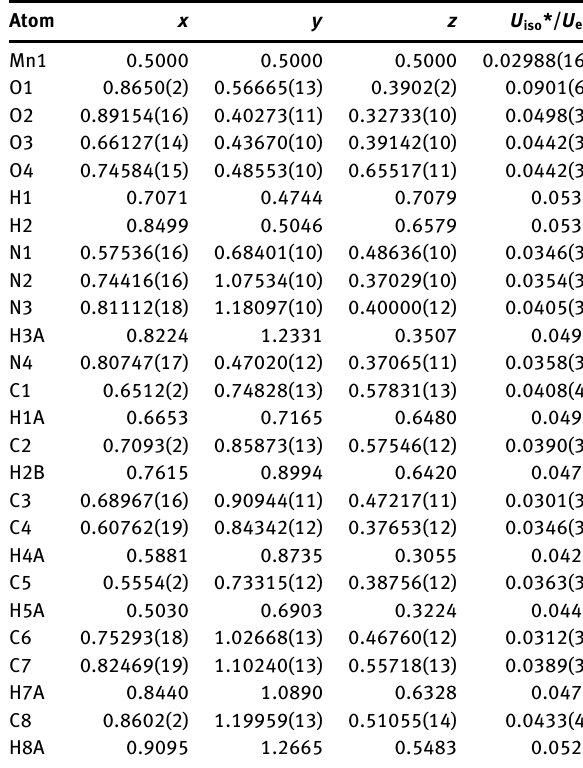
Table 2: Fractional atomic coordinates and displacement parameters (in Å 2